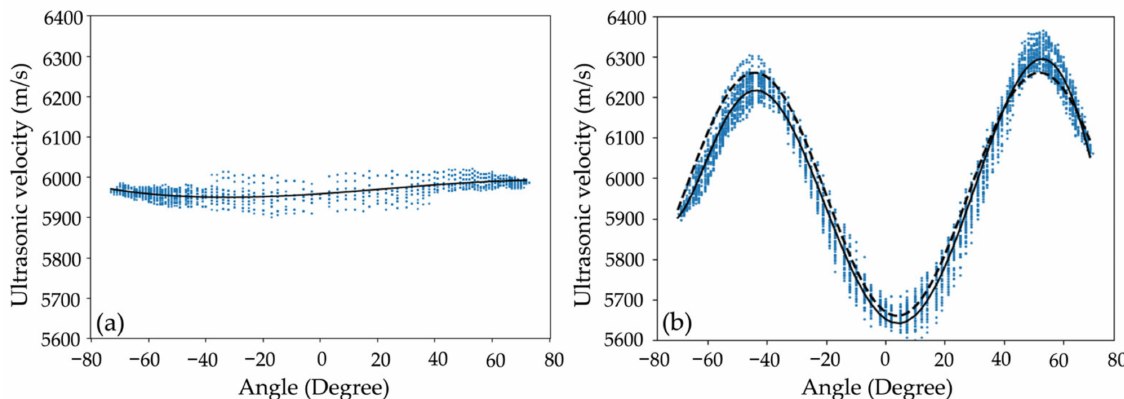
Figure 5. Variations in ultrasonic longitudinal wave velocity with the angle from the surface normal for: ( a ) the ferritic steel; ( b ) the buttering